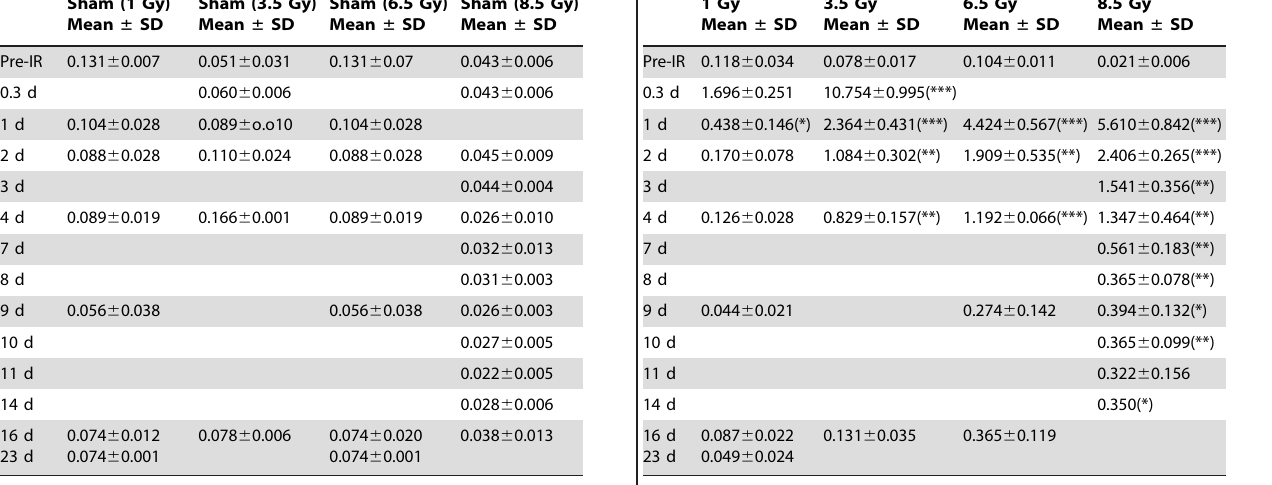
Blanks indicate no data for the corresponding times. Pre-IR: values for c -H2AX foci per cell prior to irradiation.